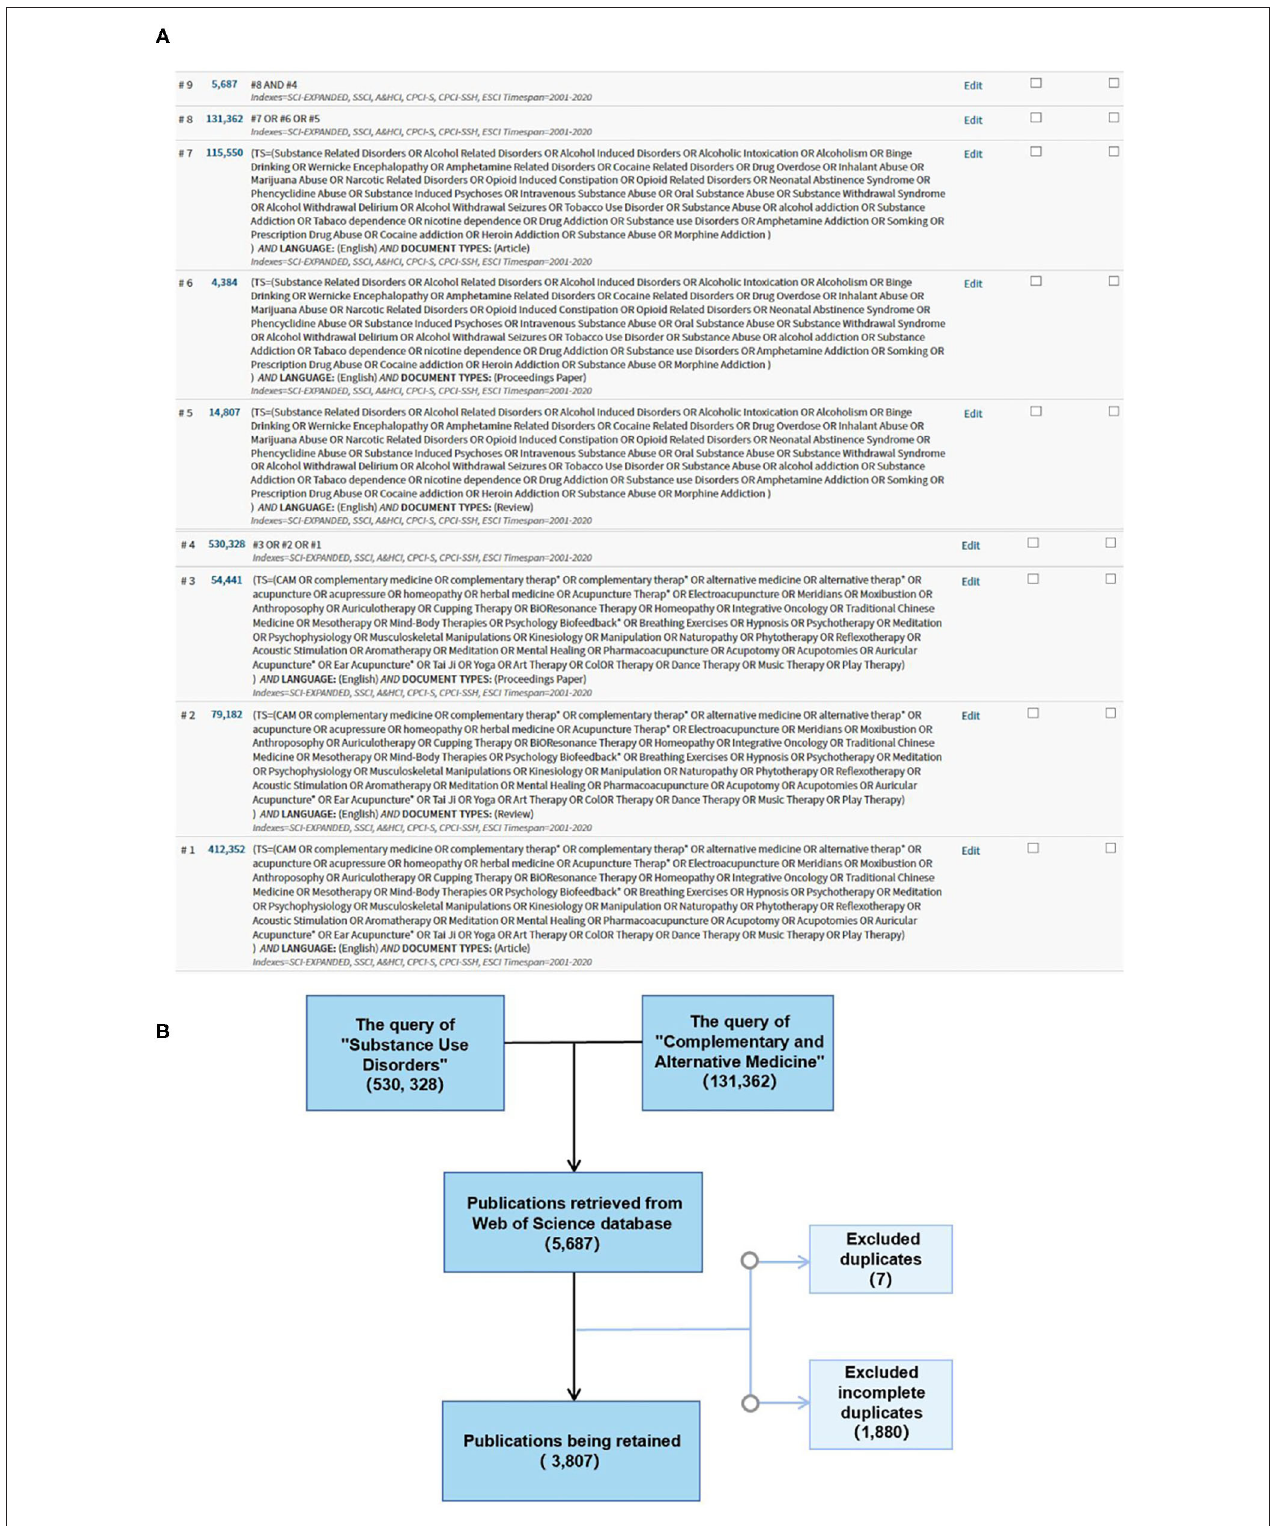
FIGURE 1 | (A) Topic search queries and (B) flowchart of the inclusion of publications.